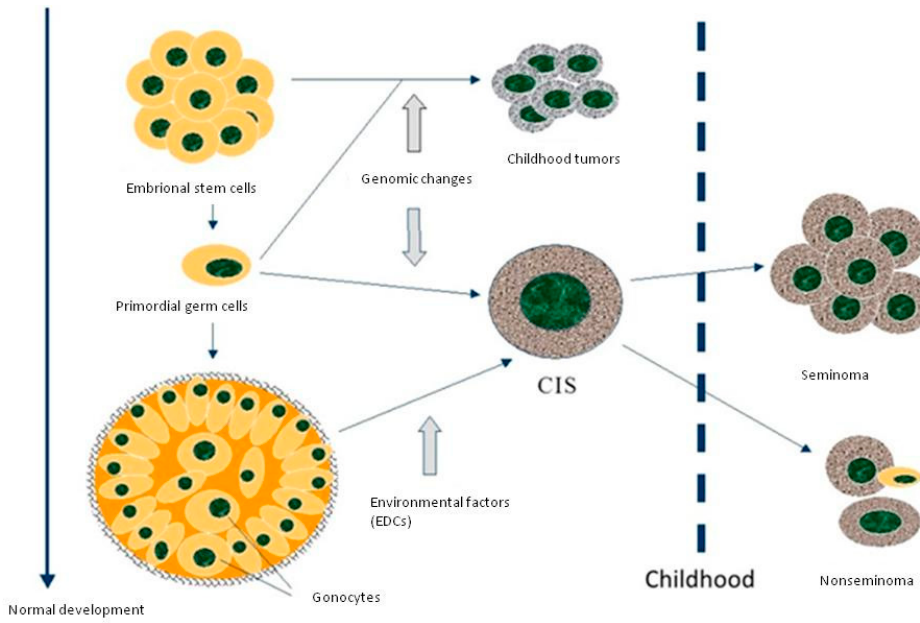
Figure 1. Histogenesis of testicular germ cell tumors.